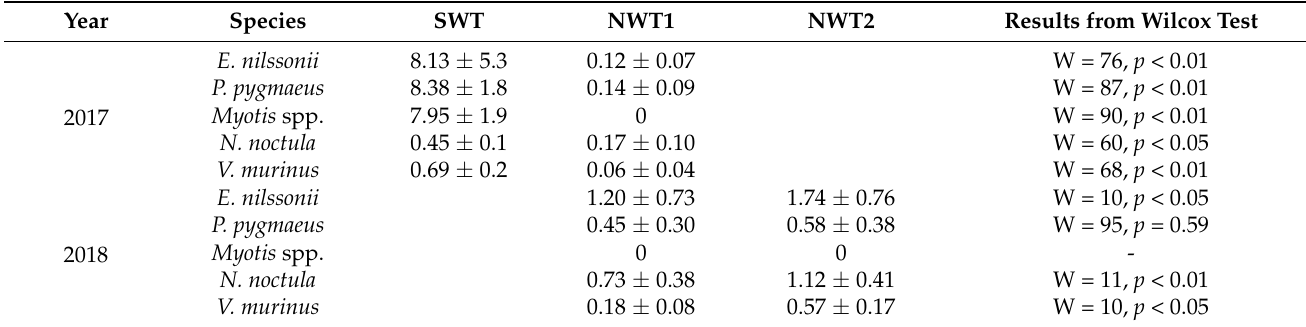
Table 5. Bat activity (number of bat passes) ± SE per night at the nacelle height for the five most common species, recorded with Avisoft equipment (n = 104 nights in 2017 and n = 137 nights in 2018). Results from the Wilcox test that compared the activity of each species between two wind